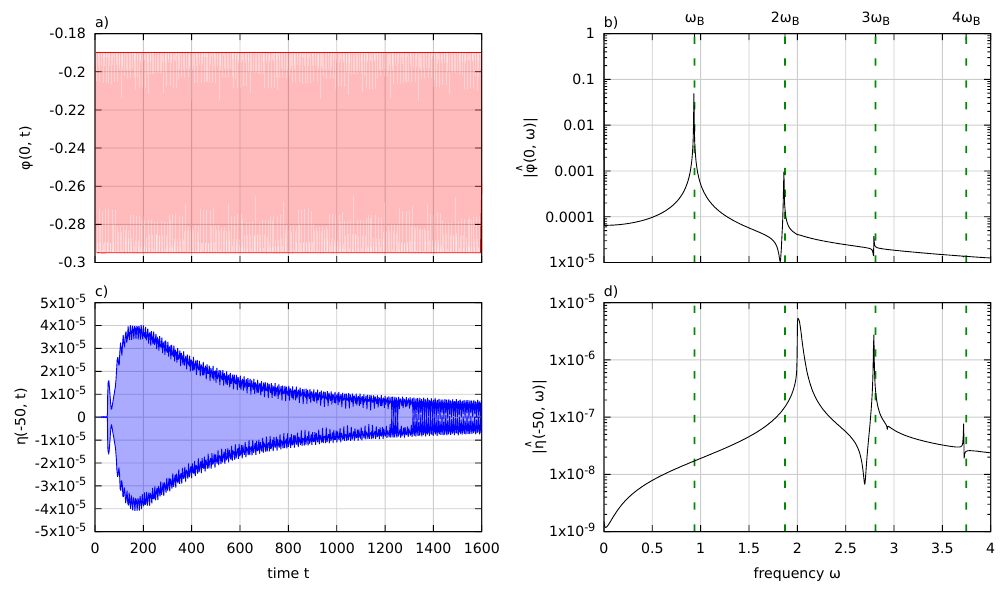
Figure 12 . The same sequence of plots as in (cid:12)gure 11, but now for H = 0 : 94 > H 2 .